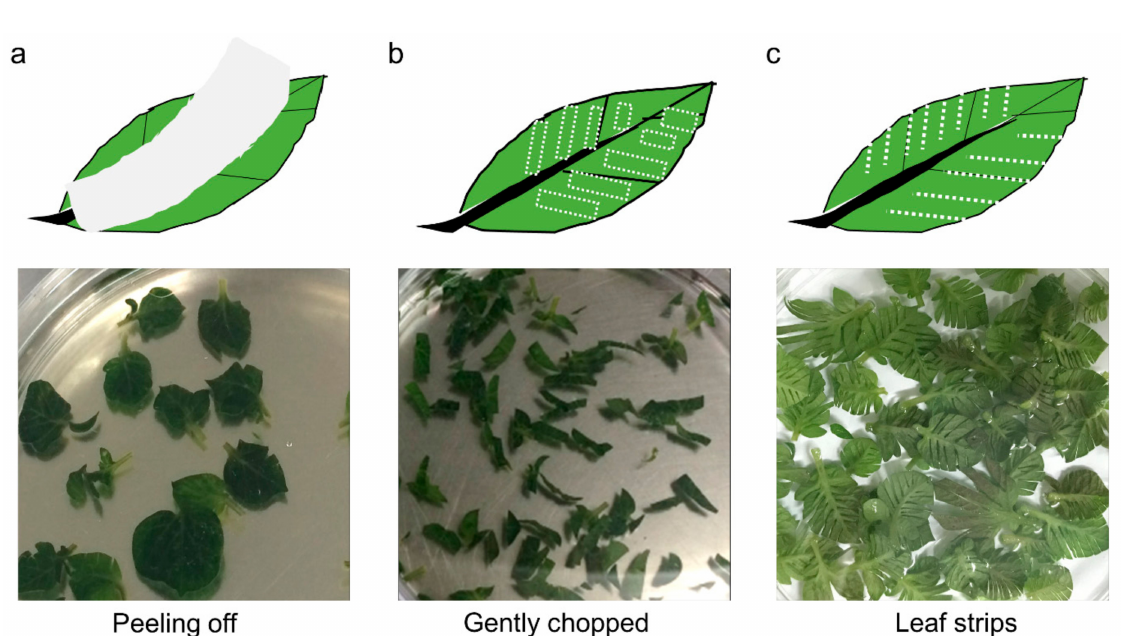
Figure 1. Three different methods of leaf wounding. ( a ) Both sides of the epidermis were adhered to clear 3M tape, and the lower epidermal layer was removed by carefully pulling away the 3M tape. ( b ) Leaves were gently chopped into approximately 0.2 × 0.7 cm 2 segments. ( c ) Partial wounds were made by removing 2–3 mm leaf strips on both sides of the midrib with a sterile